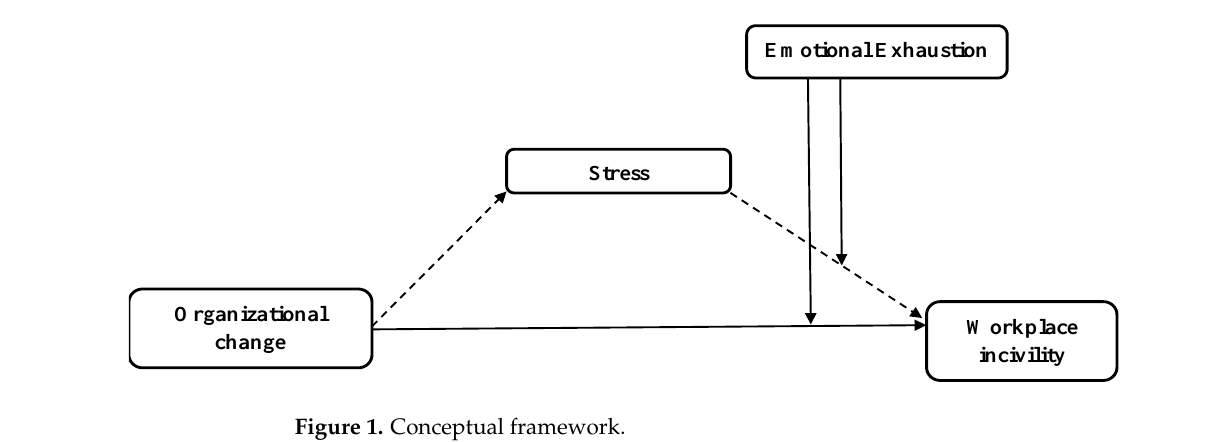
Figure 1. Conceptual framework.